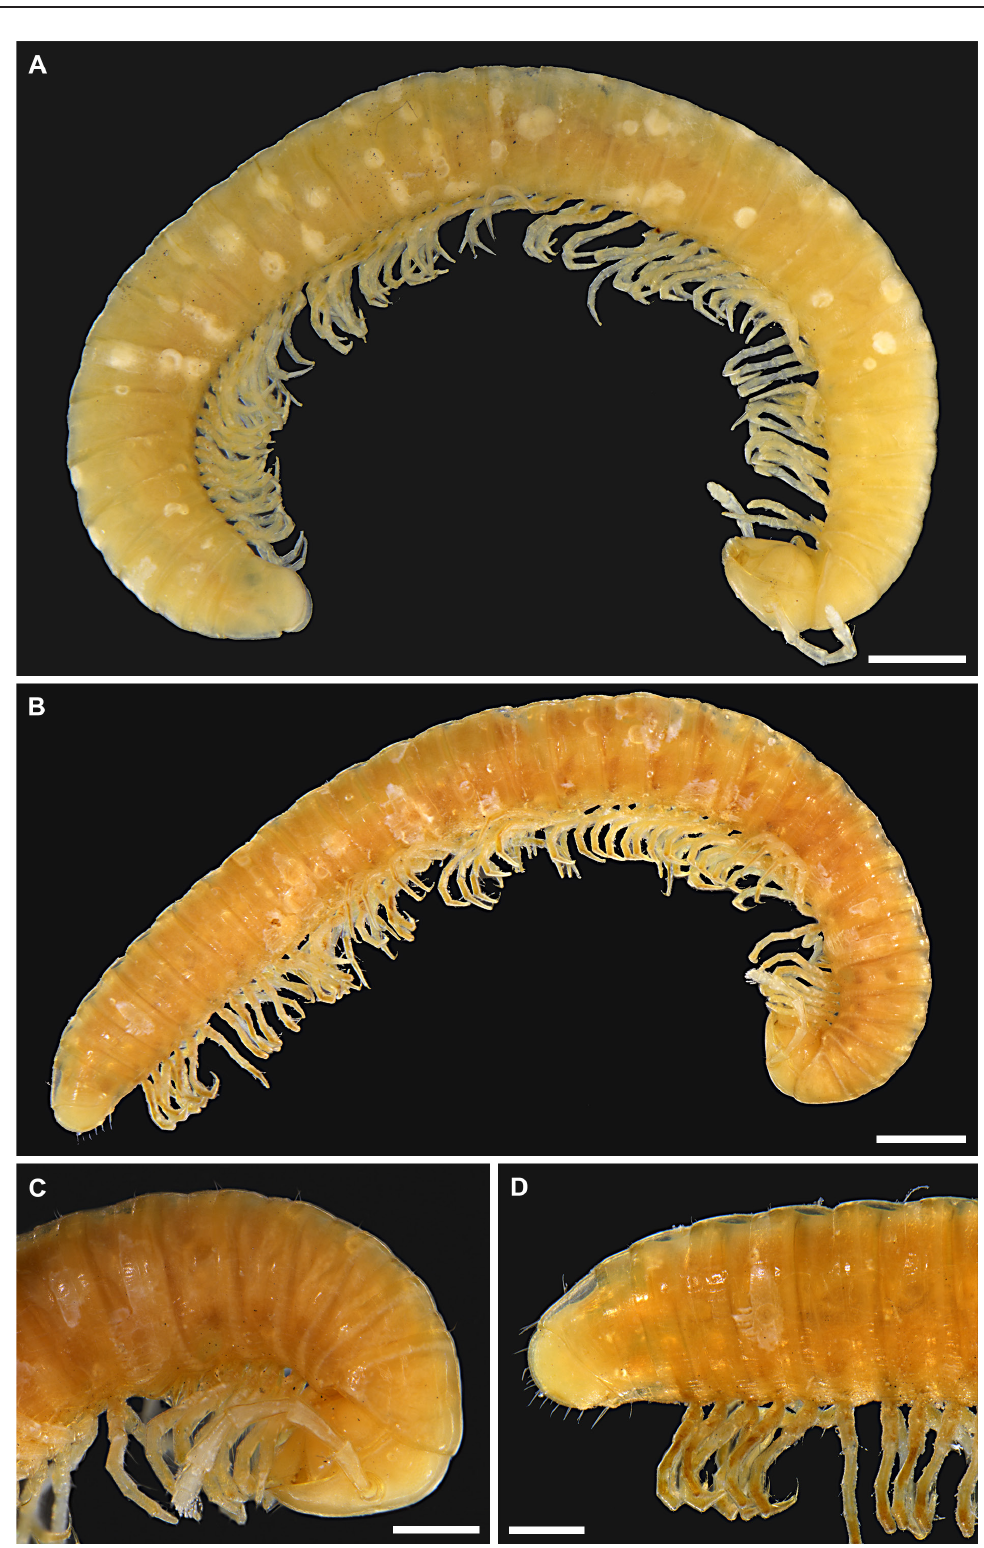
Fig. 7. Leucogeorgia longipes Verhoeff, 1930. A . Paralectotype ♂ (NHMW 9980), habitus, lateral view. B – D . Lectotype ♂ (NHMW 3063). B . Habitus, lateral view. C . Anterior part of body, lateral view. D . Posterior part of body, lateral view. Photos: Oliver Macek (NHMW). Scale bars: A–B = 1 mm; C–D = 0.5